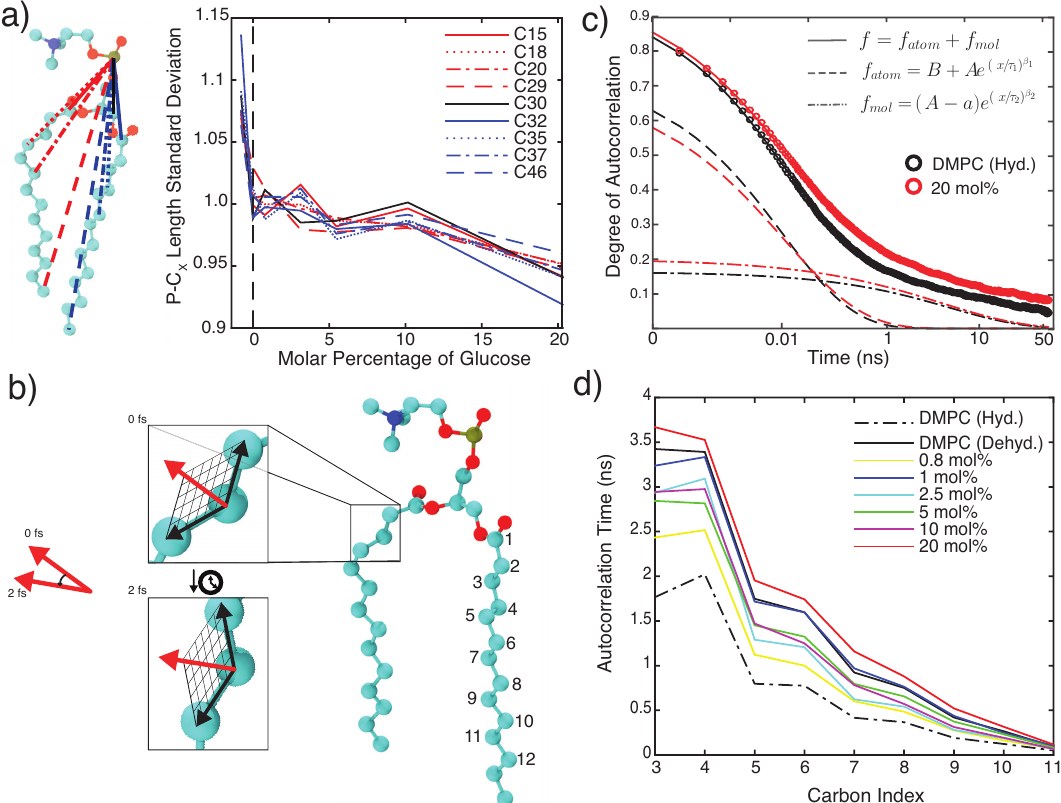
Figure 5. ( a ) Normalized standard deviations of the distances between phosphorous and various carbon atoms in the phospholipid tails as a function of glucose concentration. Blue curves use carbons from the SN2 tail, red curves use carbons from the SN1 tail, and black curves use carbons from the glycerol moiety. Data show a decrease in standard deviation with increasing sugar concentration, indicating a decrease of mobility. ( b ) Schematic showing how rotational autocorrelation was calculated. Windows of three adjacent carbon atoms on the lipid tails were selected, and the change in the vector normal to the plane generated by these three atoms was observed across 50 ns. Numbering convention of the carbon windows is shown. ( c ) Typical autocorrelation functions for 0 mol% hydrated system and 20 mol% dehydrated bilayers. Data was fitted using two stretched exponentials. ( d ) Autocorrelation time as a function of carbon window, calculated as the integral across the autocorrelation